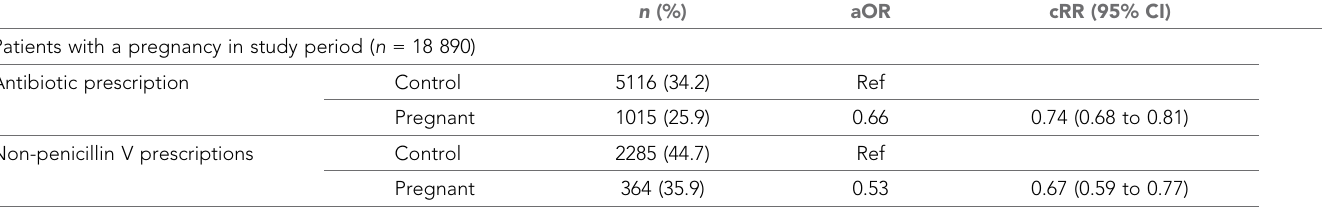
n (%) aOR cRR (95% CI)